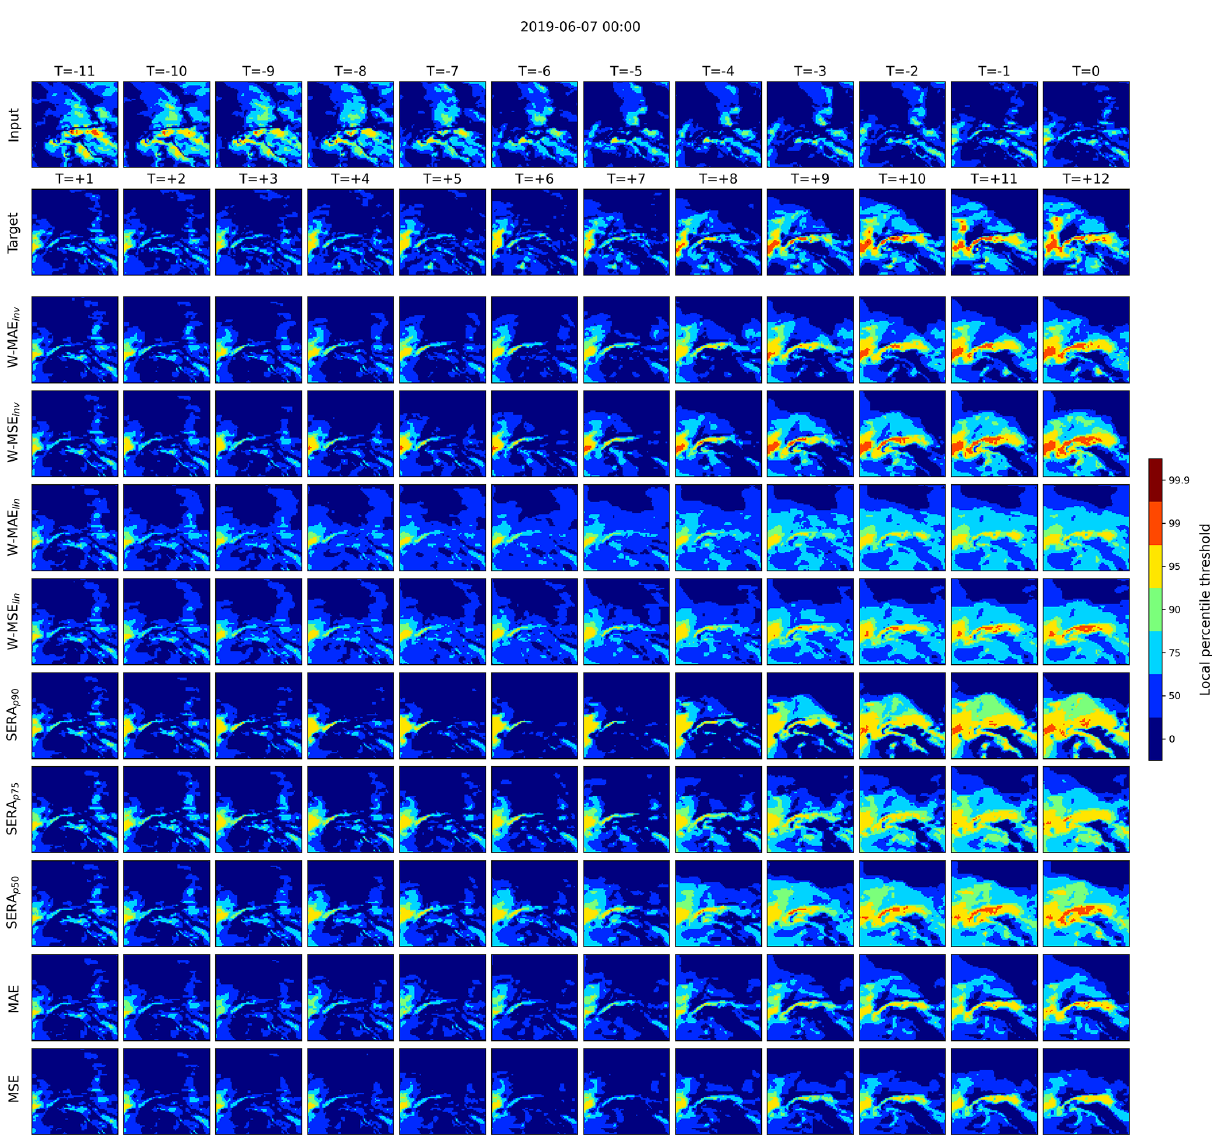
Figure 9. An example forecast from the ConvLSTM network trained with the various different loss functions. The first row from the top displays the 12 input frames, the second row the succeeding 12 target frames and the following rows the 12 predicted frames of the models. T refers to the index of the frame (in hours), with T = 0 denoting the last input frame and T = + 12 denoting the final target and prediction frames. Rather than showing the raw predictions, the predictions are categorised into binary events using percentile intensity